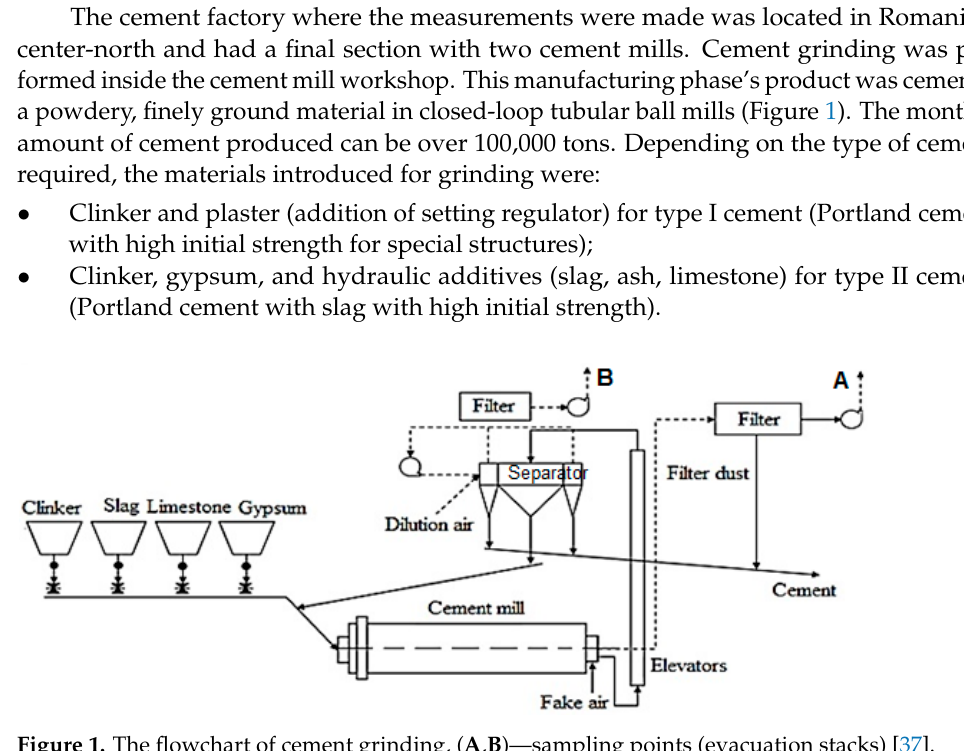
Figure 1. The flowchart of cement grinding, A, B—sampling points (evacuation stacks)